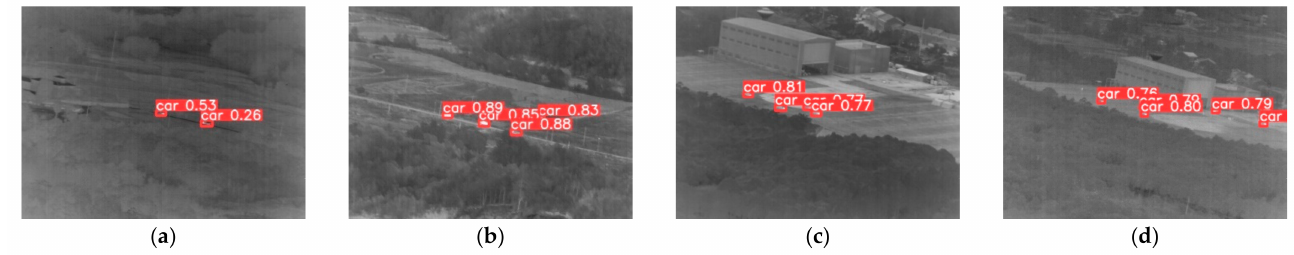
Figure 8. YOLOv5s detection map. ( a ) Scene 1. ( b ) Scene 2. ( c ) Scene 3. ( d ) Scene 4.